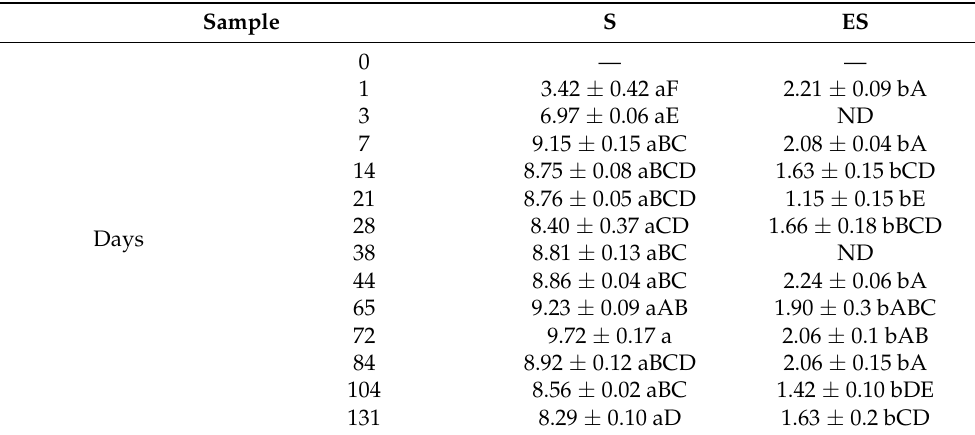
Table 13. Growth of Shew. putrefaciens (log cfu/g) in fish broth during storage for 131 days: with inoculum (S); with 8% of ethanol-water extract and inoculum